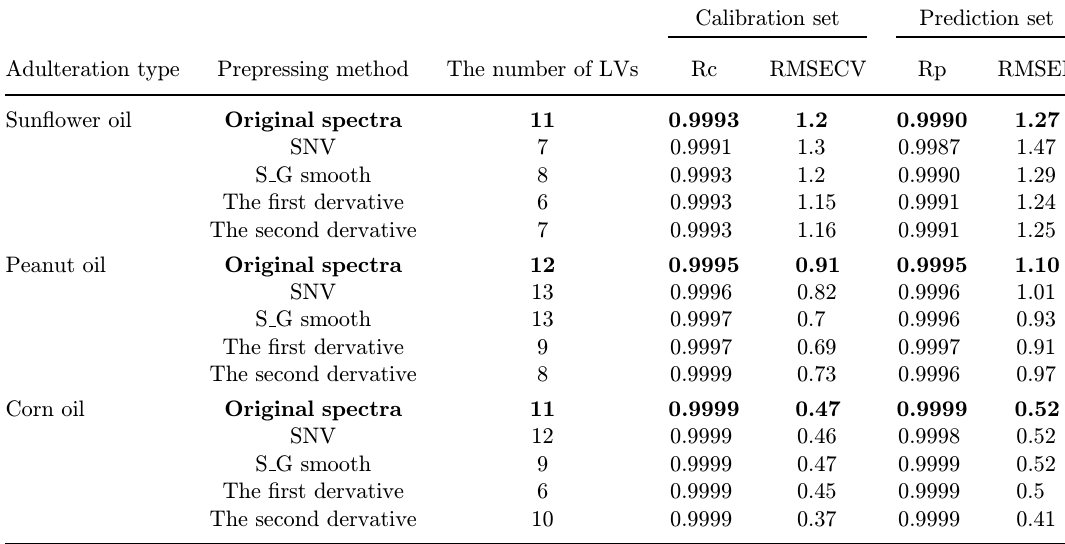
Table 1. Results of PLS models built by raw and pretreated spectra